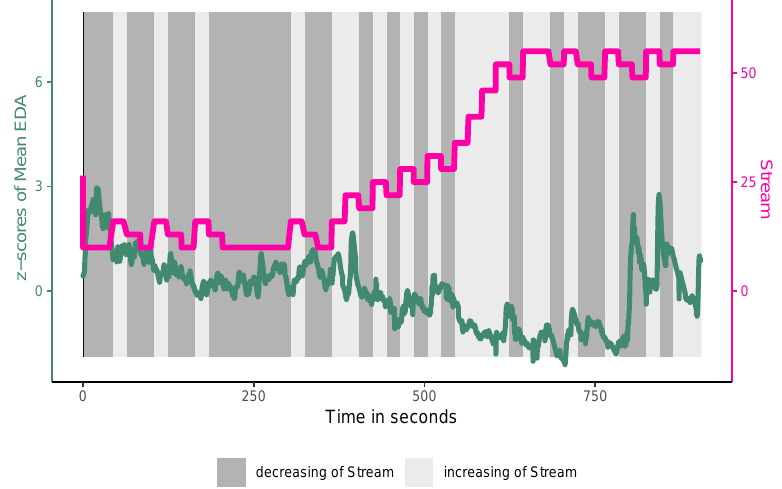
Figure 3. Adaptation across time for one participant. The pink line indicates S TREAM , the green line indicates the z-scored mean EDA signal that was used for adaptation. Grey areas indicate whether the algorithm chose to increase (light grey) or decrease (dark grey) the S TREAM in a time window of 20